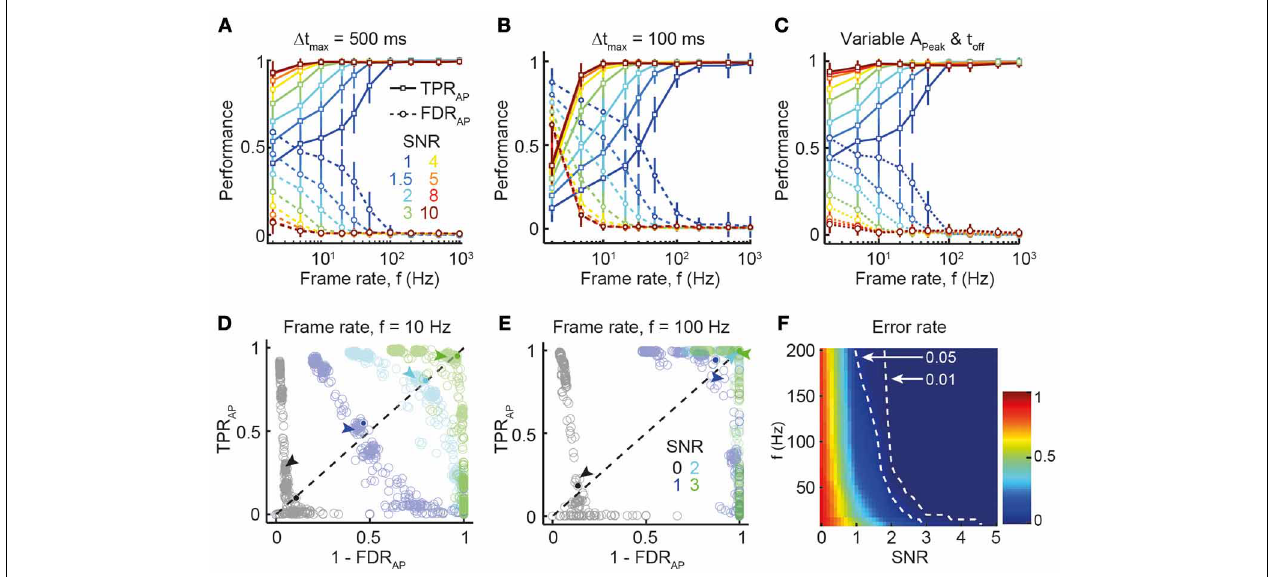
points indicate different combinations of Schmitt-trigger thresholds for the spike reconstruction algorithm (see Materials and Methods). Arrows mark the data points corresponding to thresholds employed for reconstruction in this study. Solid circles indicate the break-even point used for quantifying overall reconstruction performance. The error rate is the normalized distance of the break-even point from the top-right corner (perfect reconstruction accuracy). (E) Same analysis as (D) at f = 100Hz frame rate. Marked data points for SNR 2 and 3 are superimposed in top-right corner, indicating near-perfect reconstruction accuracy. (F) Error rate for all combinations of SNR and frame rate (linear interpolation between simulated parameter combinations). Dashed lines indicated thresholds for 0.01 and 0.05 error